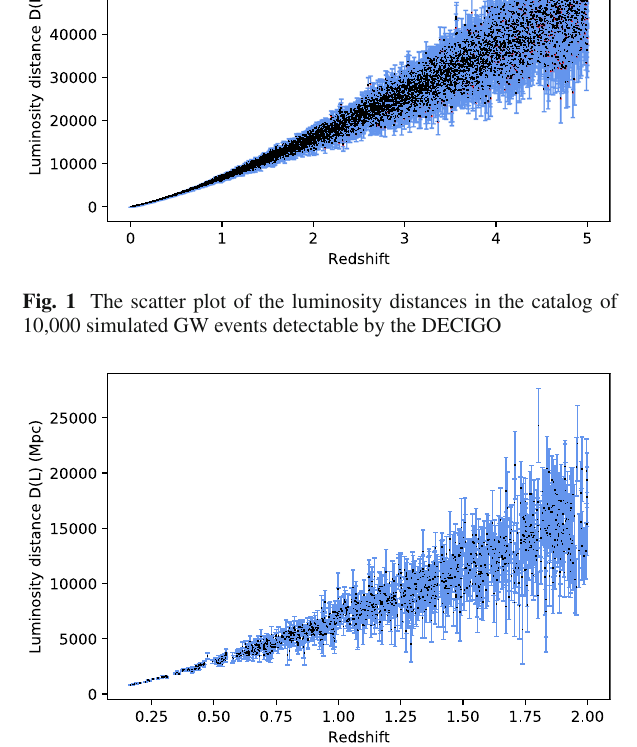
Fig. 2 The scatter plot of the luminosity distances in the catalog of 1000 simulated GW events observable by the third generation detector